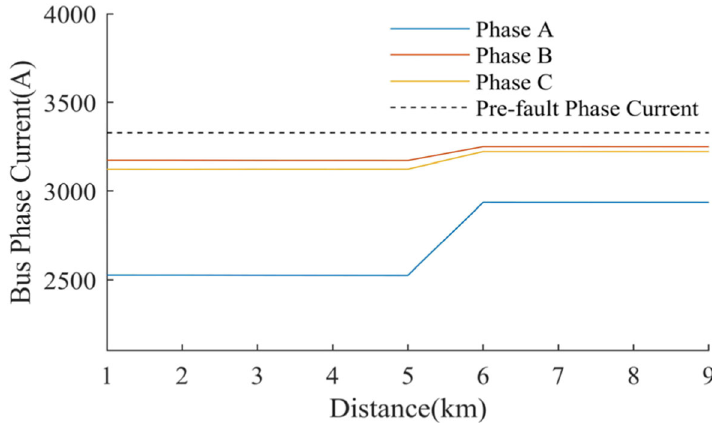
Fig. 6 Bus phase current variation with fault